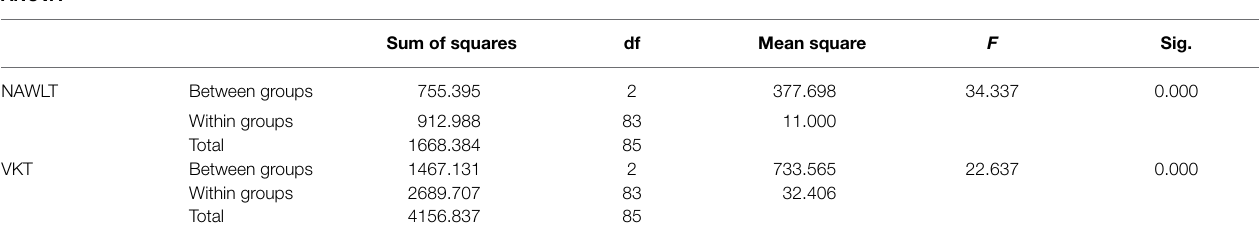
TABLE 6 | One-way between-groups ANOVA for the scores on post-test. ANOVA